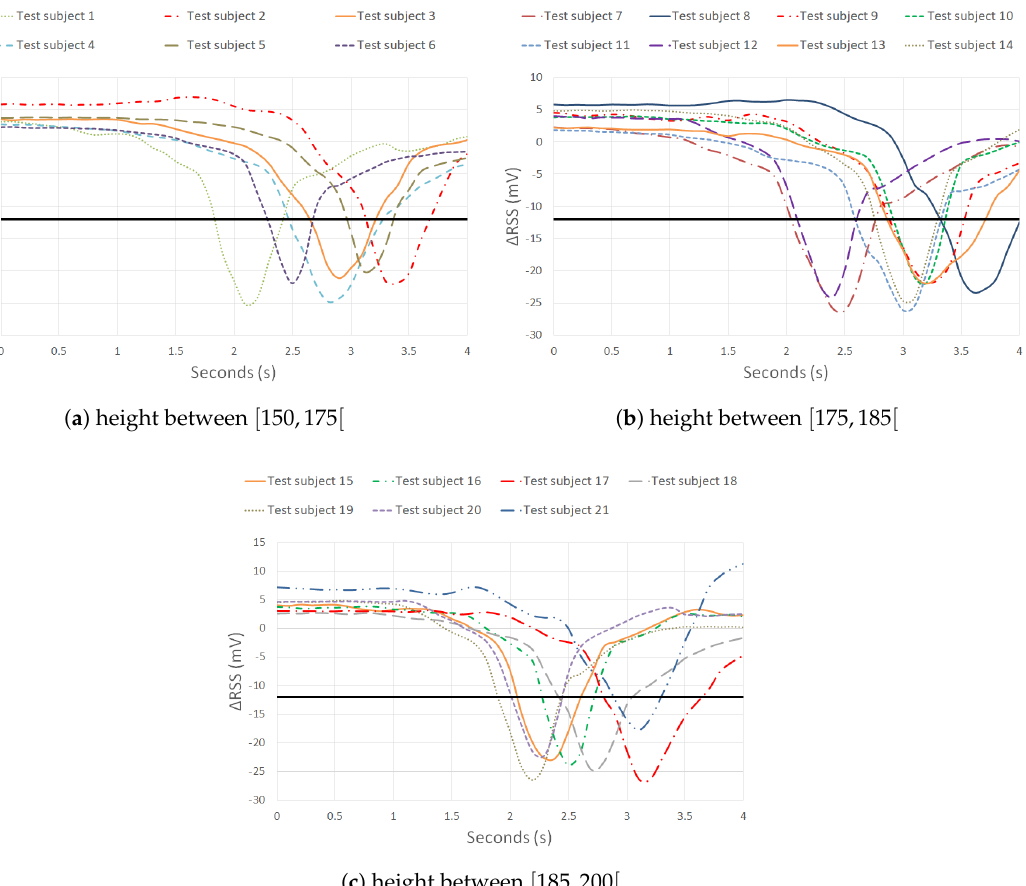
Figure 11. ∆ RSS lapse of different